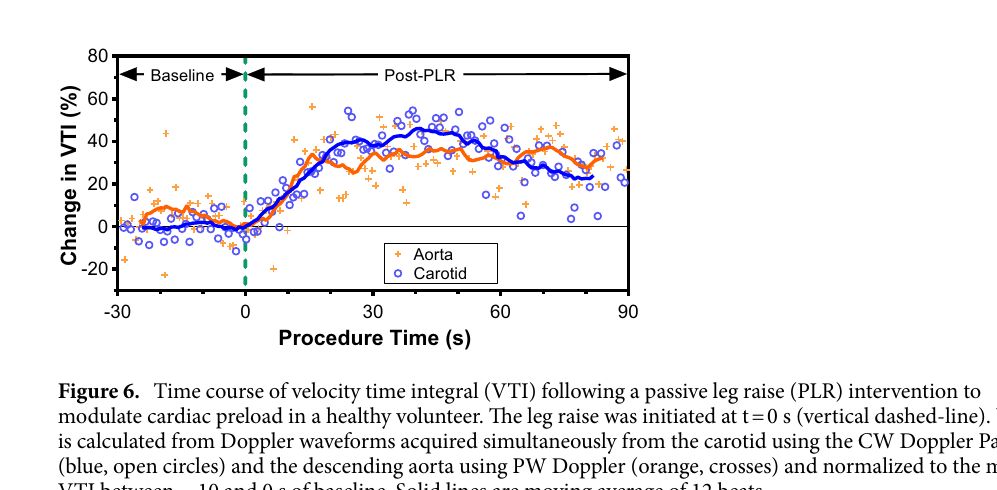
Figure 5. ( a ) Continuous carotid Doppler waveform monitoring with automatically traced maximum velocity envelope (white line). ( b ) Beat-to-beat quantification of carotid velocity time integral (VTI).